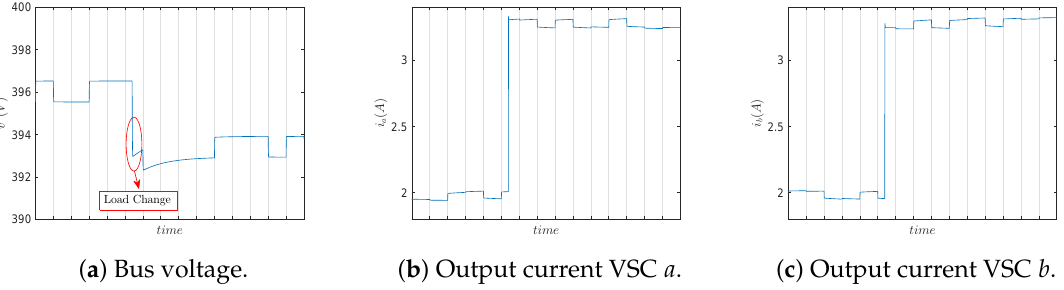
Figure 6. TDMA-based binary power talk: two VSC units (obtained with PLECS R (cid:13) simulation of the system shown in Figure 5, r d = 2 Ω , v n a = v n r = 100 Ω changing to r = 60 Ω